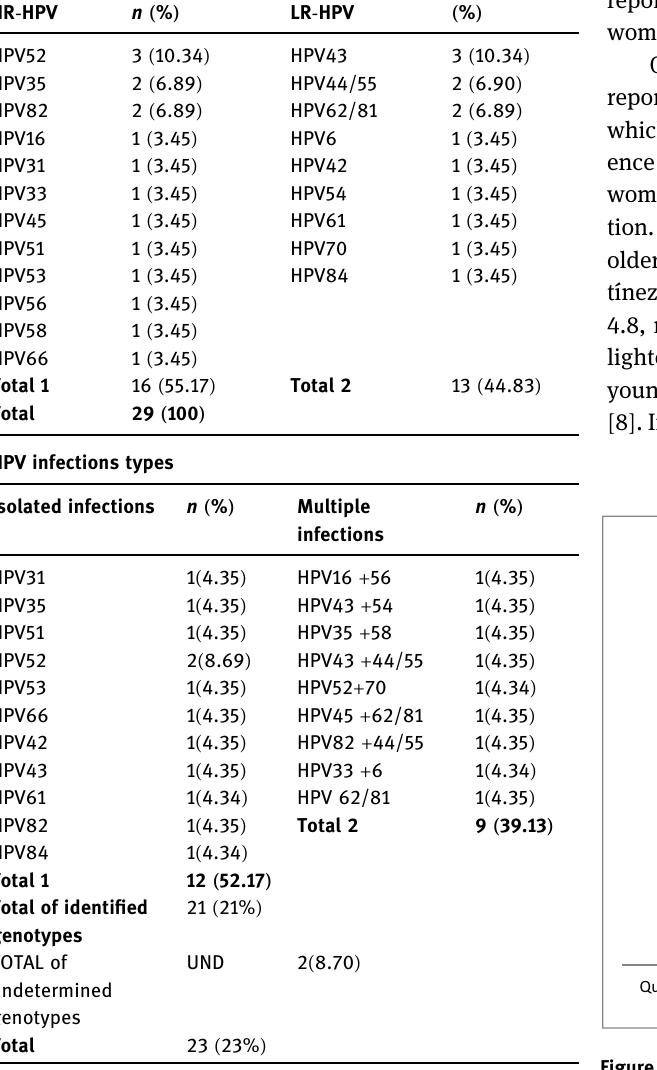
Prevalence of HPV genotypes in pregnant women